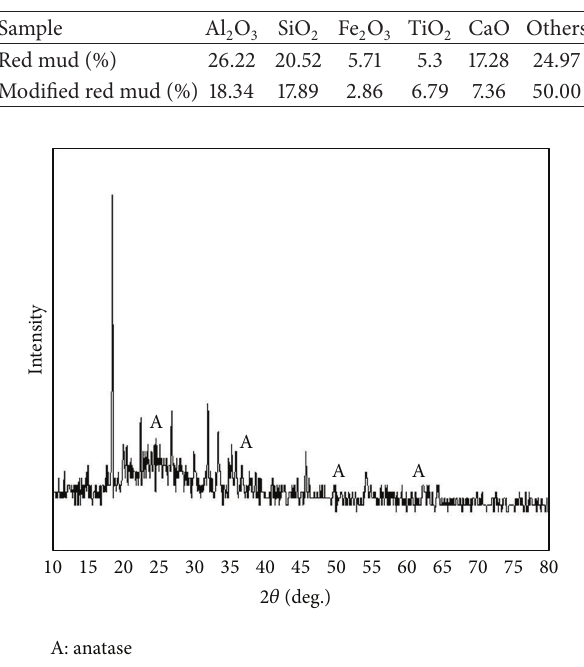
Figure 1: XRD pattern of modified red